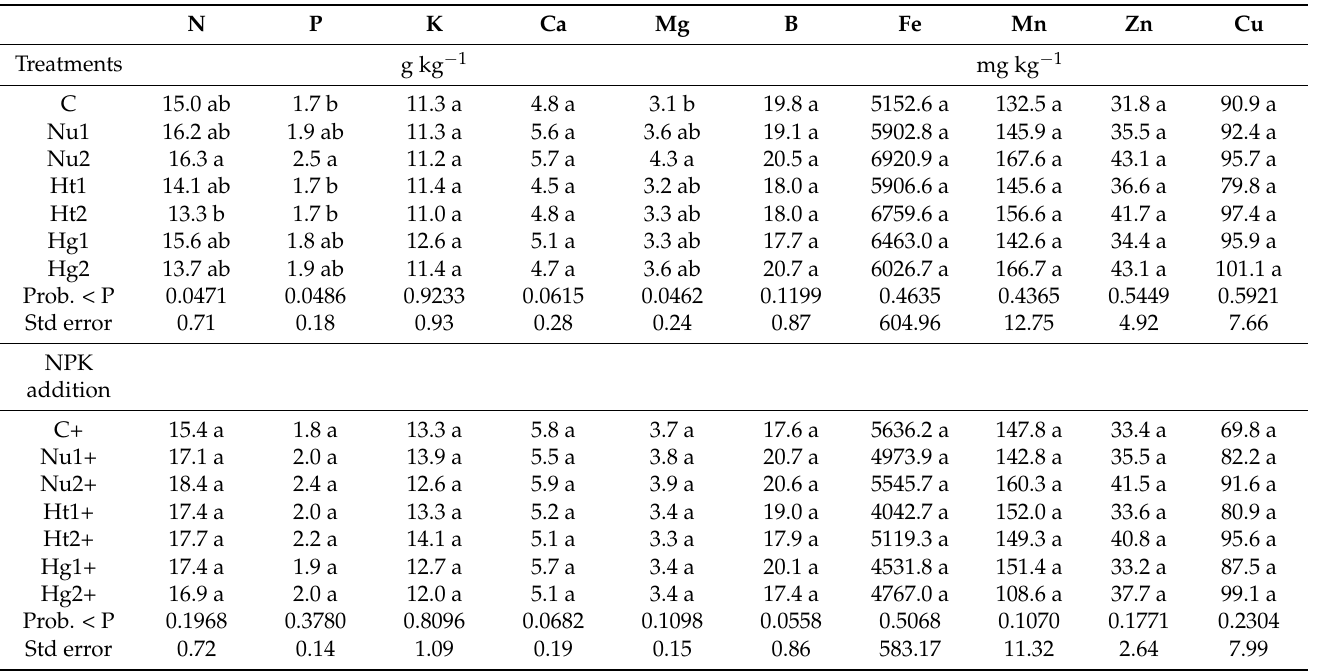
Table 4. Root nutrient concentration in response to the application of organic amendments (C, Control; Nu, Nutrimais; Ht, Humitec; and Hg, Humic gold, applied at two rates (1,2)), in experiments without and with NPK(+) mineral fertilization. For each independent experiment, means followed by the same letter are not significantly different by Tukey HSD test ( α =